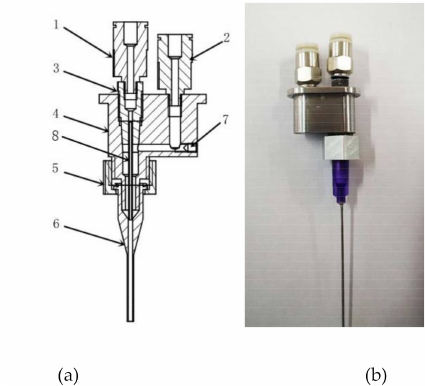
Figure 2. Optimized nozzle structure of 3D bioprinter. 1—Quick-connect ( a ), 2—Quick-connect ( b ), 3—Cone holder, 4—Nozzle body, 5—Set Nut, 6—pinhead, 7—Sealing screw, and 8—Capillary